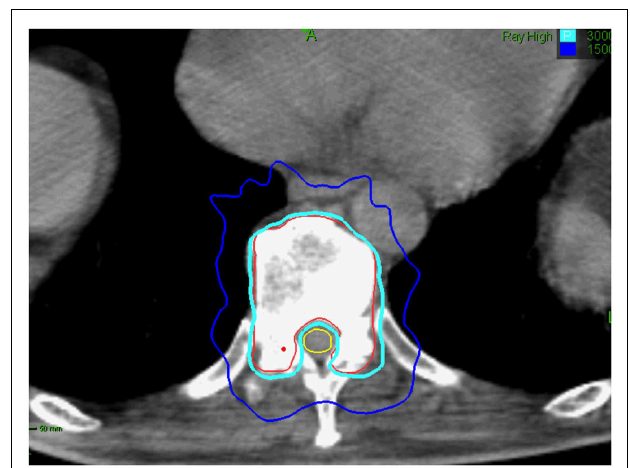
FIGURE 4 | Seventy-five-year-old gentleman with oligometastatic prostate cancer and aT11 vertebral body metastasis .The decision was to proceed with ADT and SBRT. ADT was initiated.The vertebral body was treated with 30Gy in 5 fractions.Treatment planning axial computed tomography images demonstrating the GTV (red) and spinal cord (yellow). Isodose lines shown as follows: 100% of the prescription dose (light blue line) and 50% of the prescription dose (dark blue line).The maximum point to the spinal cord and esophagus were 30 and 35Gy, respectively